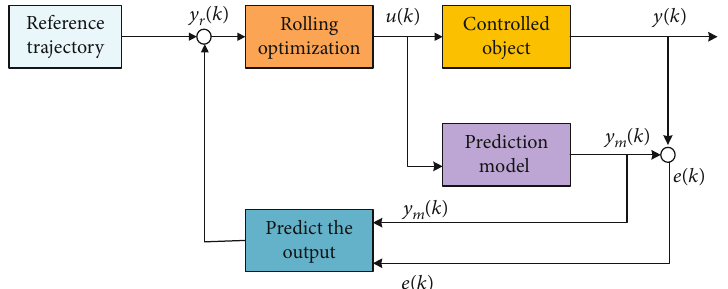
Figure 2: The principle of the MPC